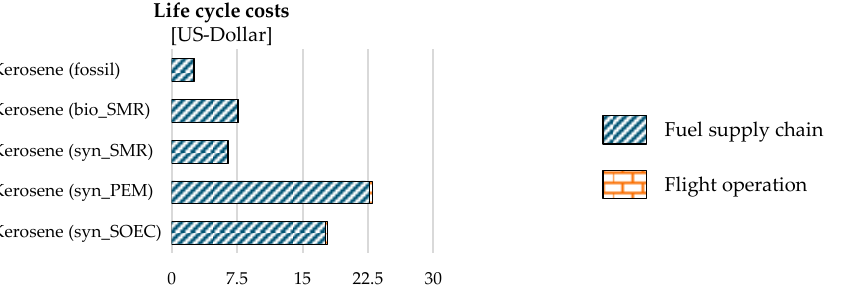
Figure 5. Comparison of the life cycle costs per 100 pkm for SAFs and fossil kerosene and breakdown of the impact scores regarding the fuel supply chain and flight operation.